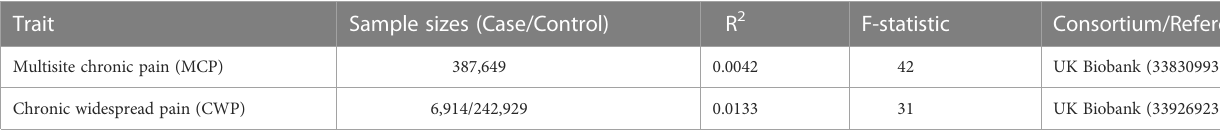
TABLE 1 Details of GWAS studies for pain-related traits. Trait